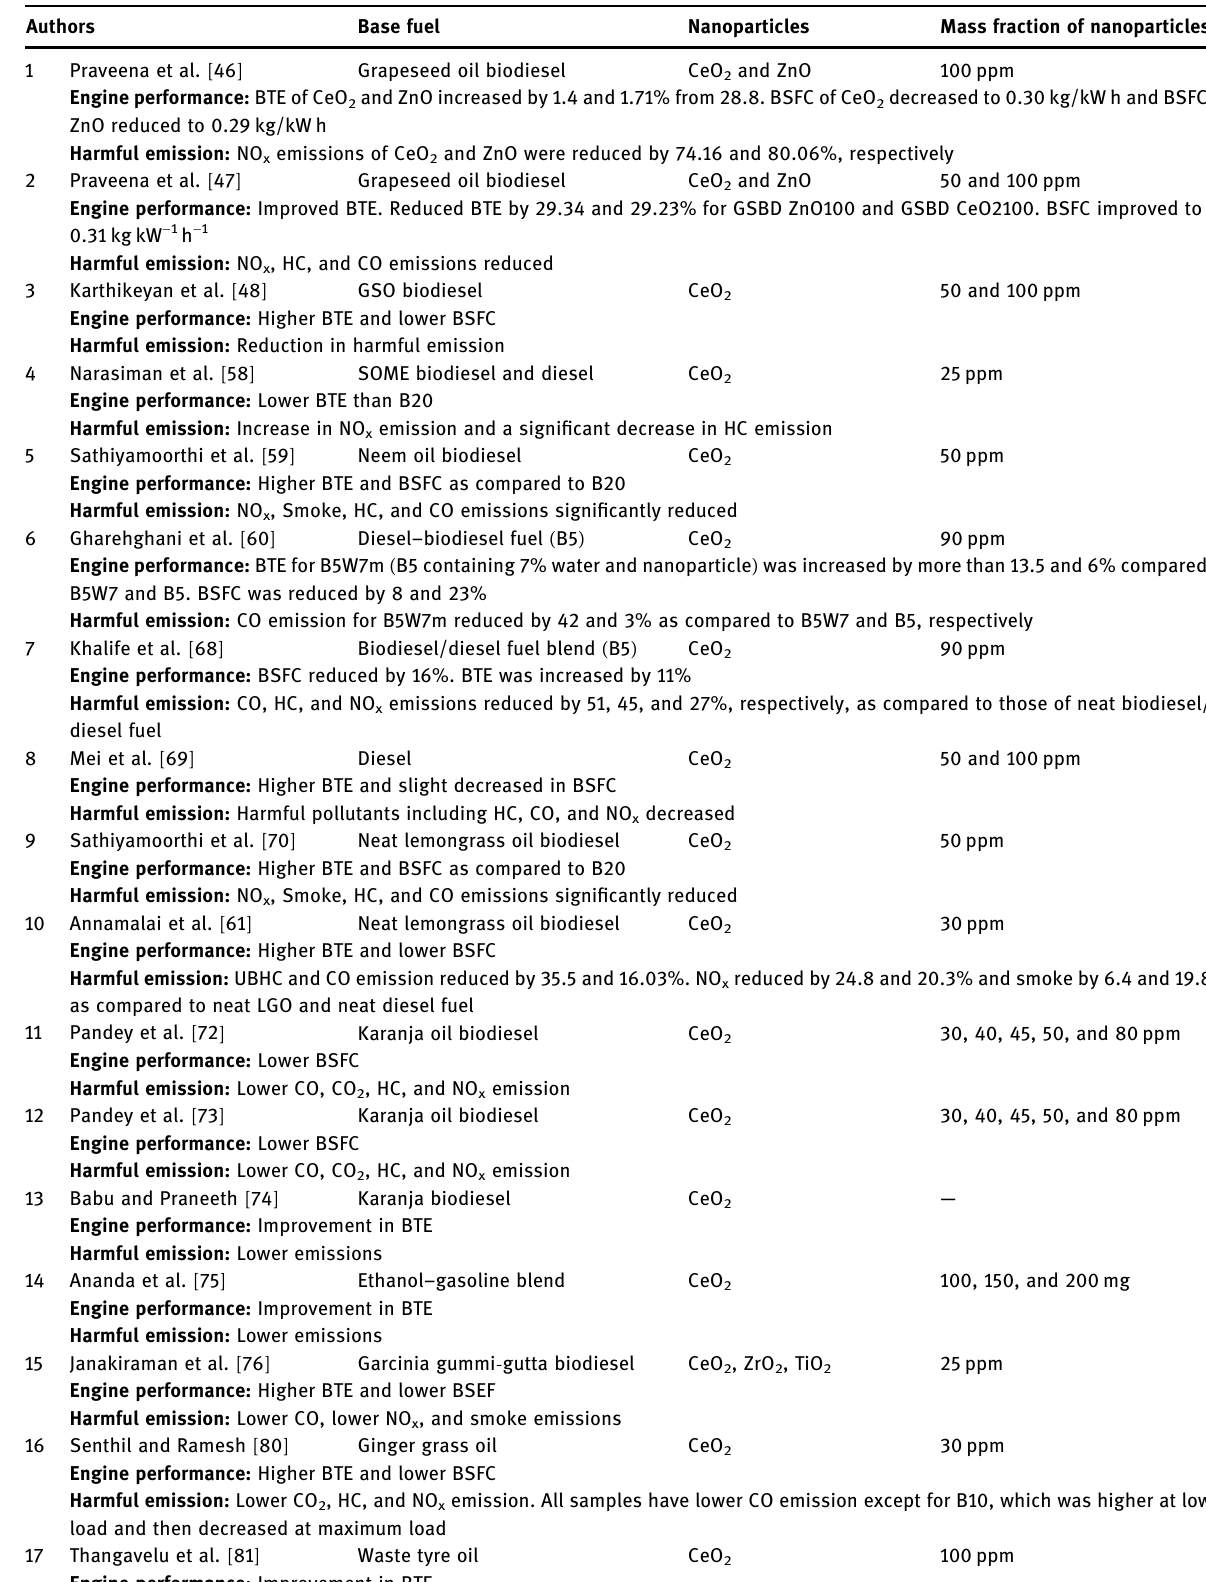
Table 2: Summary of CeO 2 nanoparticle studies as an additive in diesel/biodiesel fuel Authors